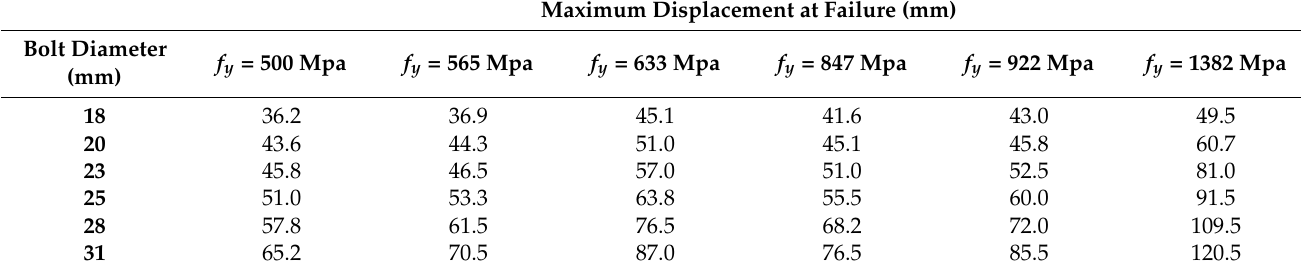
Table 12. Maximum static displacement of